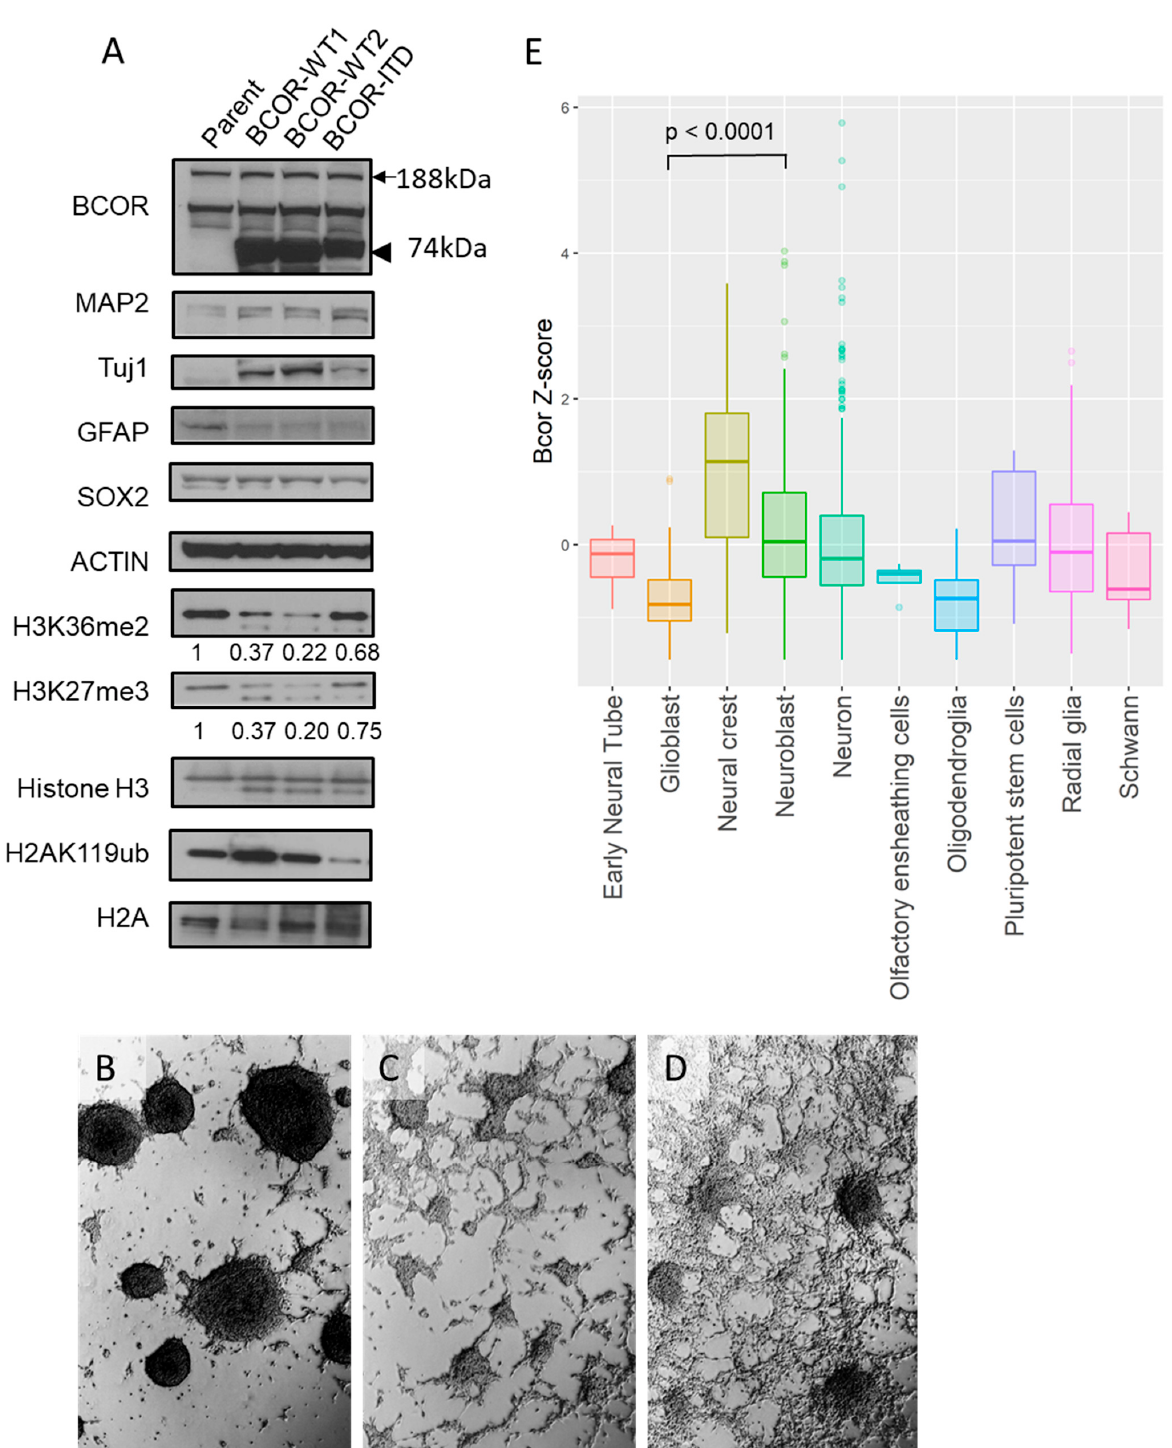
Figure 3. Both BCOR E7–15 -WT and BCOR E7–15 -ITD alter differentiation of mNSC. ( A ) Representative western blots of BCOR, MAP2, Tuj1, GFAP, SOX2, beta-Actin, H3K36me2, H3K27me3, histone H3, H2AK119Ub, and histone H2A in mNSC, mNSC BCOR E7–15 -wildtype (WT1 and WT2), and mNSC BCOR E7–15 -ITD. Arrow and arrowhead indicate endogenous and exogenous BCOR, respectively. ( B – D ) Microscopic images of parent mNSC cells ( B ), mNSC BCOR E7–15 -WT ( C ), and mNSC BCOR E7–15 -ITD ( D ). ( E ) Bcor mRNA expression in mouse developing brains single cell RNA-seq. A significant difference between glioblast to neuroblast ( p < 0.0001, Mann–Whitney test) is indicated.